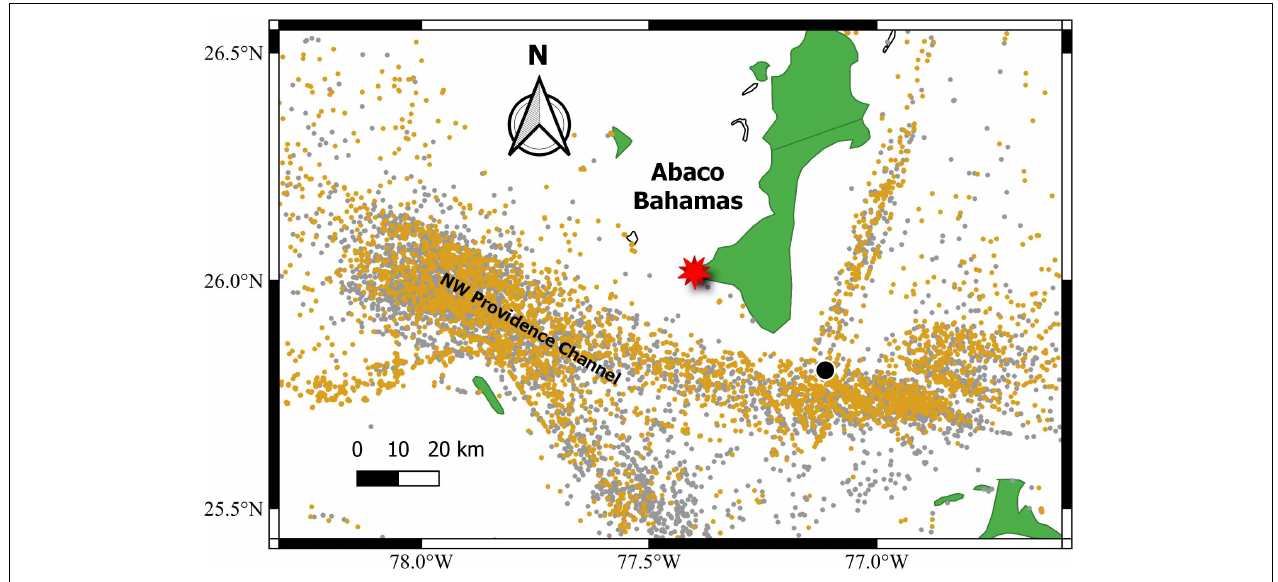
FIGURE 2 | Map of Northwest Providence Channel (NPC) depicting ship location messages transmitted and received by AIS receiver station 844 (red star) for the pre-COVID-19 time period (ship locations in gray, n = 6,449) and during COVID-19 (ship locations in orange, n = 5,692) during corresponding times when the ST500 hydrophone (black circle) was deployed. Each ship is represented by one location per day.